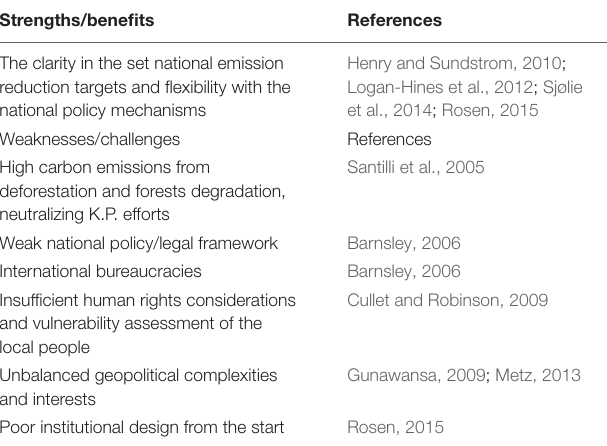
TABLE 3 | Key strengths and weaknesses related to the development of the Kyoto protocol. Strengths/benefits